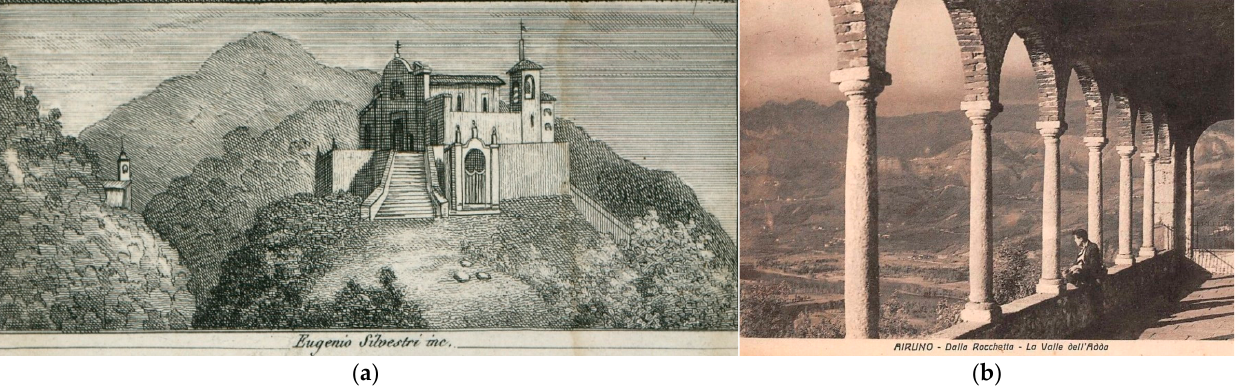
Figure 3. ( a ) Print of the Airuno sanctuary represented in the early 1900s; ( b ) the small loggia built at the end of 1700.